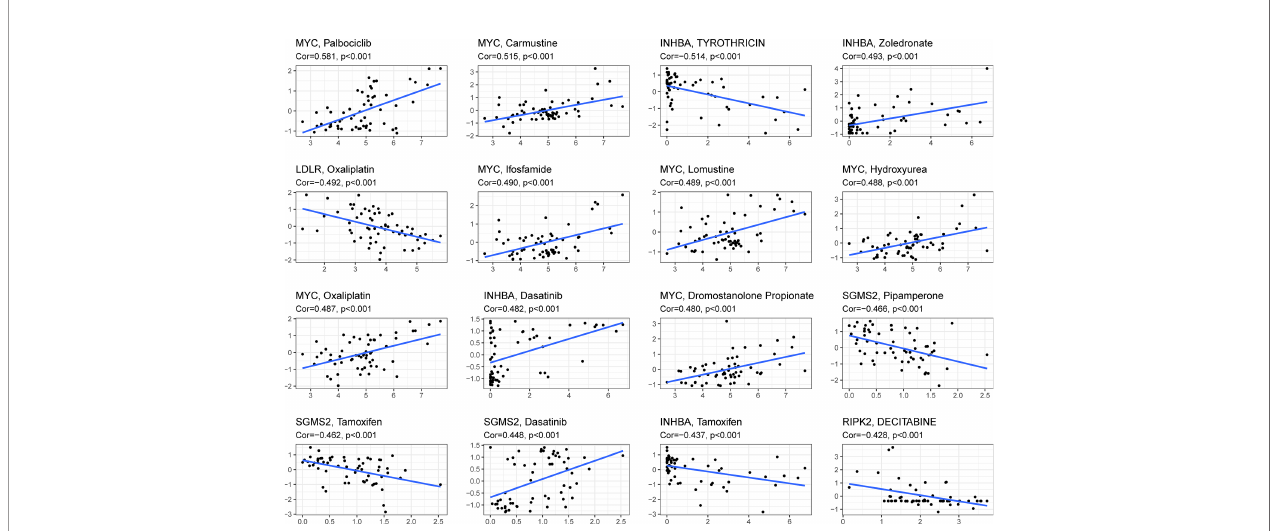
FIGURE 8 | Scatter plot of relationship between prognostic gene expression and drug